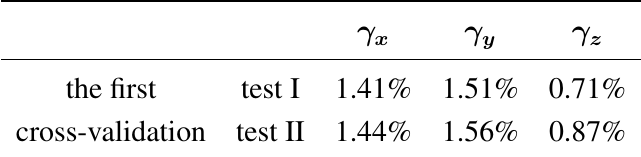
Table 5. Error analysis of decoupling by (cid:15) -SVRs when a gross error is